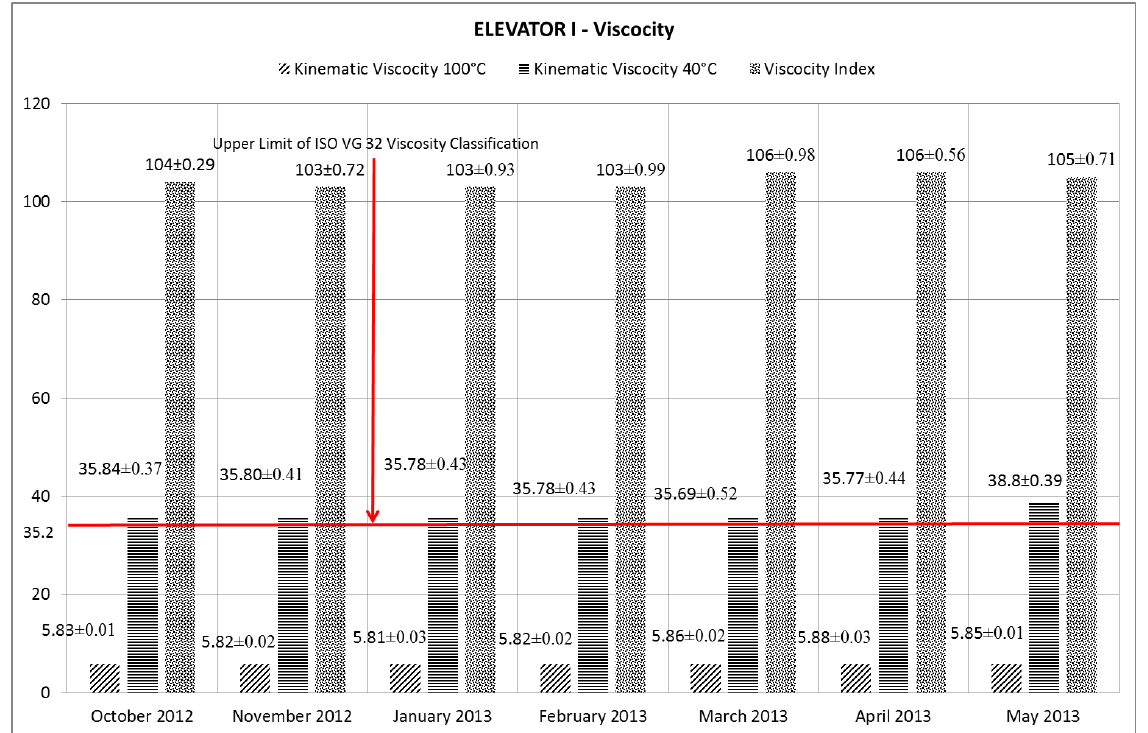
Figure 1. Viscosity in Elevator